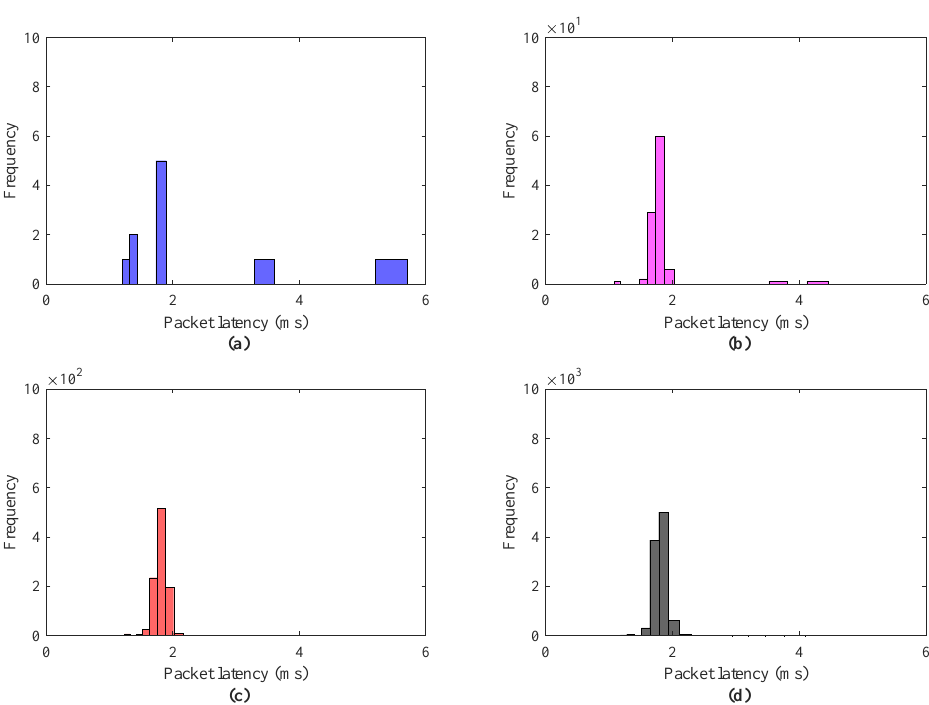
Figure 10. Packet latency histogram for scenario I haptic data transmission; ( a ) data packets = 10, ( b ) data packets = 100, ( c ) data packets = 1000, ( d ) data packets = 10,000.